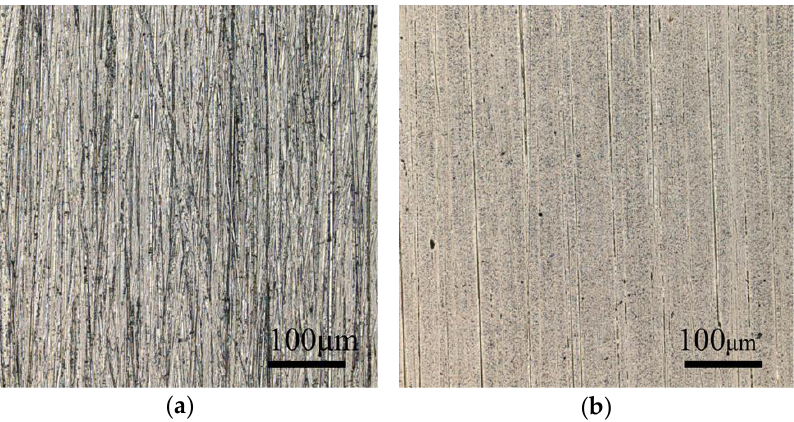
Figure 2. Surface 2D optical profilometers of the used 38CrMoAlA steel plate ( a ) and QBe2 beryllium bronze rod ( b ).